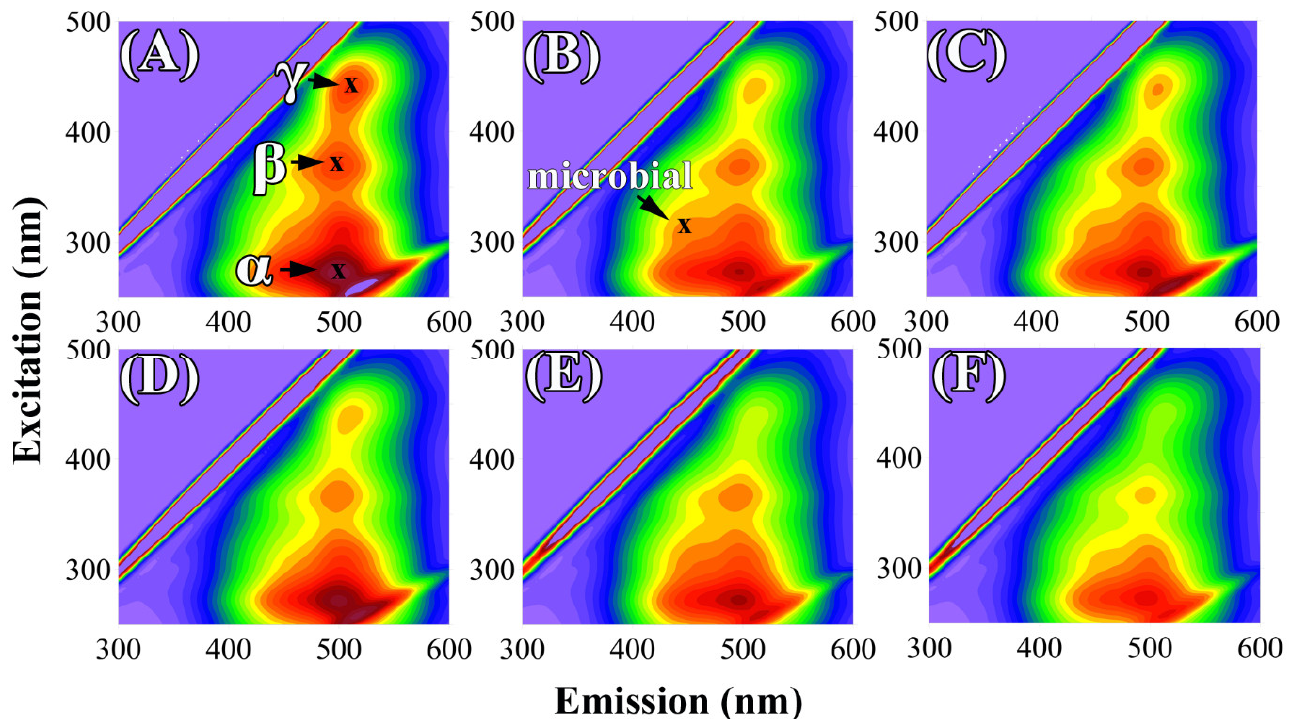
Figure 3. Exemplary EEM landscapes of humic acids (HAs) from different variants of soil samples collected in early April of the second year of experiments (T3): ( A )—S + NPK from Brunic Arenosol (BA) soil; ( B )—S + NPK + F from BA soil; ( C )— S + NPK + B from BA soil; ( D )—S + NPK from Abruptic Luvisol (AL) soil; ( E )—S + NPK + F from AL soil; ( F )—S + NPK + B from AL soil. S + NPK—soil with NPK, S + NPK + F—soil with fungal strains and NPK, S + NPK + B—soil with bacterial strains and NPK.